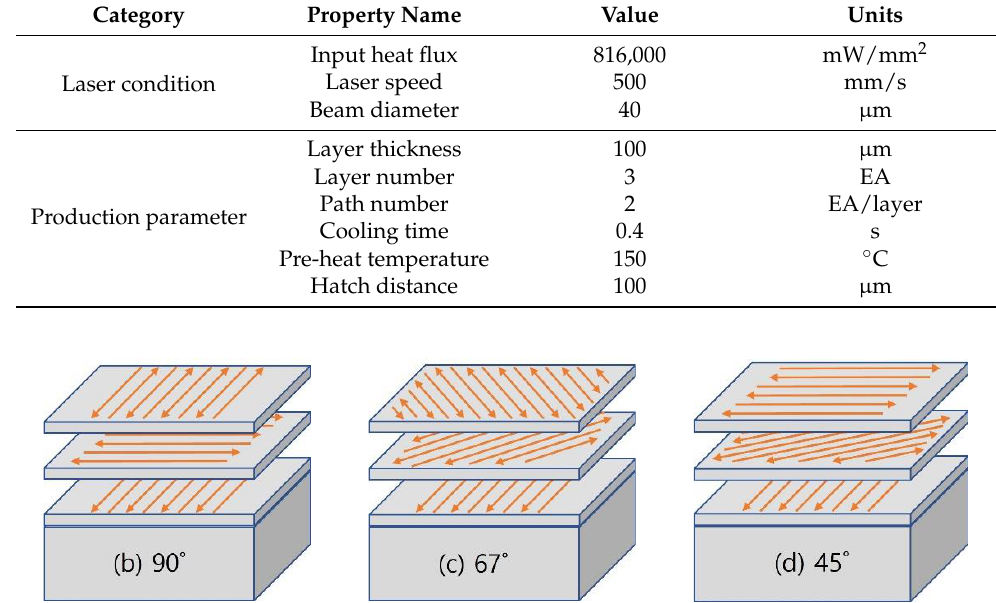
Table 1. Process parameter of single path simulation.